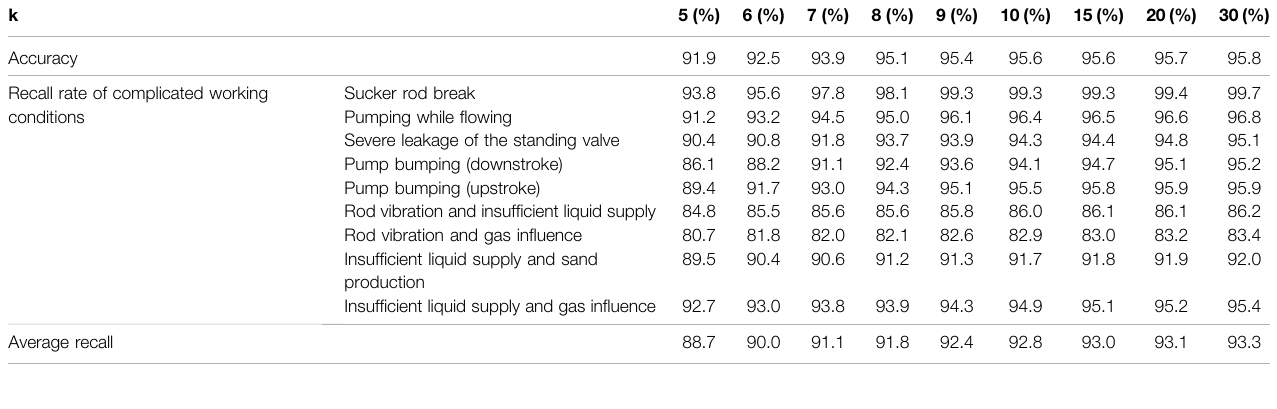
TABLE 7 | Model performance under different multi-scale normalized k values.